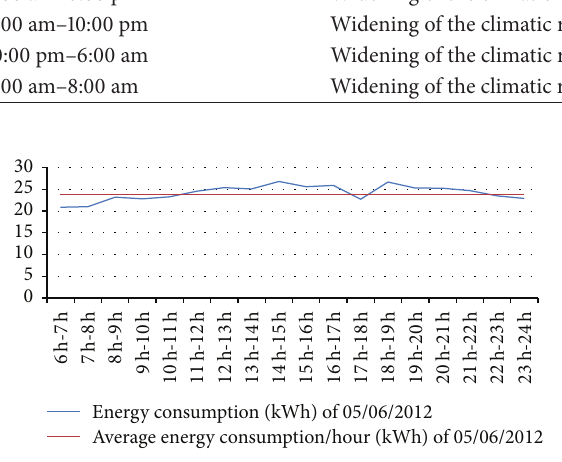
Figure 9: Hourly energy consumption curve of 05/06/2012.